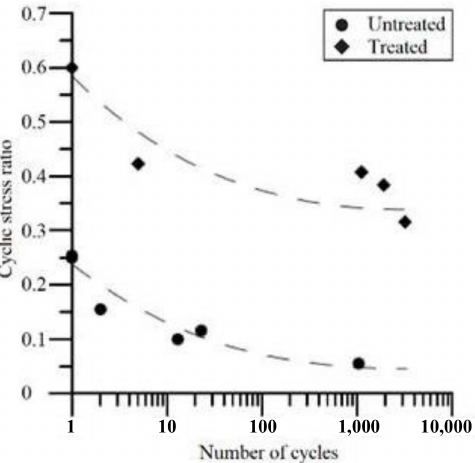
Figure 8. The relationship between cyclic stress ratio and number of cycles to liquefaction for sand samples treated by MICP